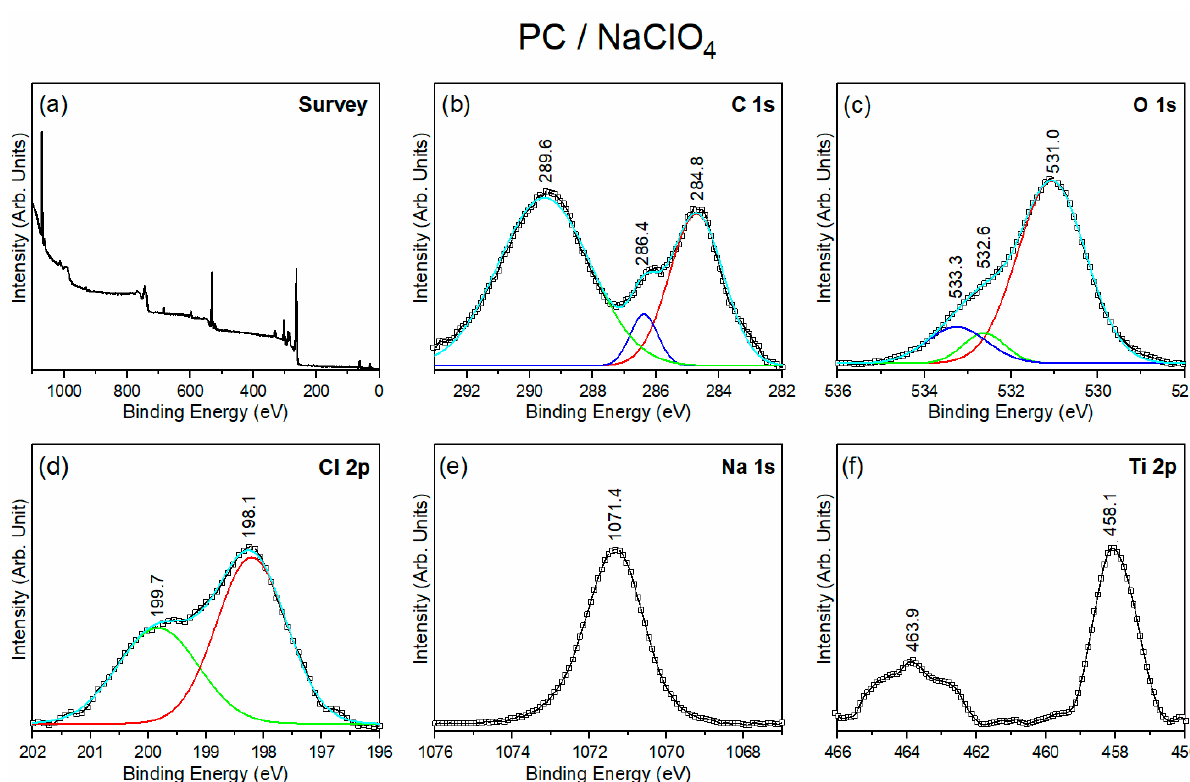
Figure 7. High-resolution XPS spectra of TiO 2 nanosheet electrodes after 30 cycles in PC / NaClO 4 electrolyte solution for ( a ) survey, ( b ) C 1s, ( c ) O 1s, ( d ) Cl 2p, ( e ) Na 1s, ( f ) Ti 2p.